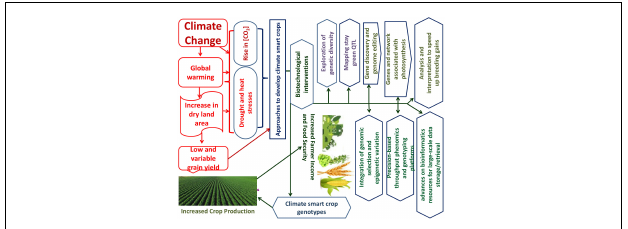
FIGURE 1 | Biotechnological innovations to improve cereal and legume production in dryland environment under climate